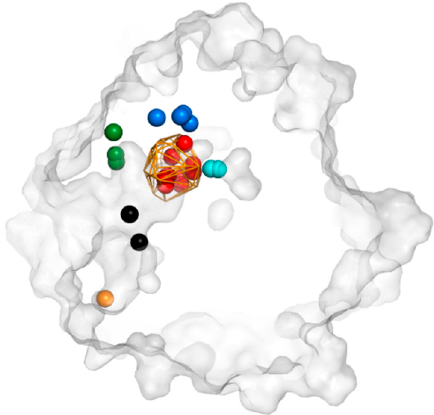
Figure 6. An example of identified hot-spots by AQUA-DUCT in 5th MD simulation. Protein cross-section is shown as a grey surface, object representing approximation of the active site by orange wireframe. Hot-spots are presented as balls and were identified in: active site (red), cavity I (blue), cavity II (cyan), entry to tunnel TC/M (green), entry to tunnel TM2 (orange) and in funnel interior (black).